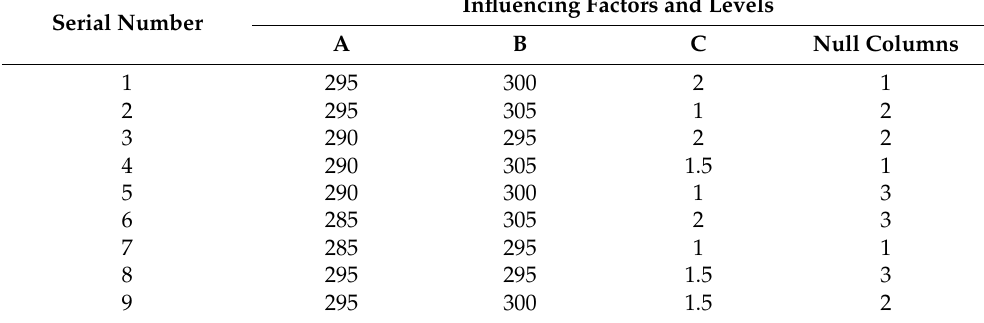
Table 6. Orthogonal test scheme.